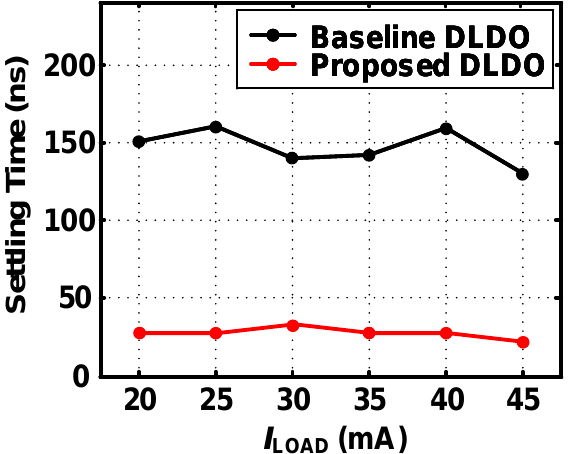
Figure 10. The settling time with I LOAD change. As shown in Figures 11 and 12, the output voltage with a load current range from 20 to 100 mA and a line voltage range from 1 to 1.2 V are simulated. The effect of the load current and the line voltage on the output voltage is not slight, a load regulation of 0.3 mV/mA and a line regulation of 0.1 mV/mV are achieved. Due to the quantization interval of the TDC-based converter is about 25 mV, the output voltage error in variations of simulation environment is acceptable.